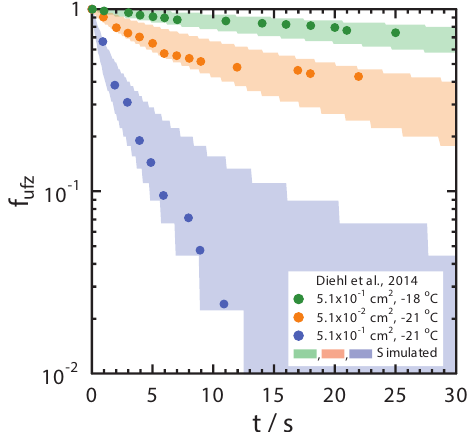
Figure 3. Simulated and experimentally (Diehl et al., 2014) derived unfrozen droplet fractions, f ufz , as a function time, t , using illite. Model simulated 5th and 95th percentile bounds of f ufz are shown as green, orange and blue shading for IsoDI1, IsoDI2 and IsoDI3, respectively. Temperature and average surface area per droplet re- ported by Diehl et al. (2014) are given in the legend. Parameter values for model simulations are given in Table